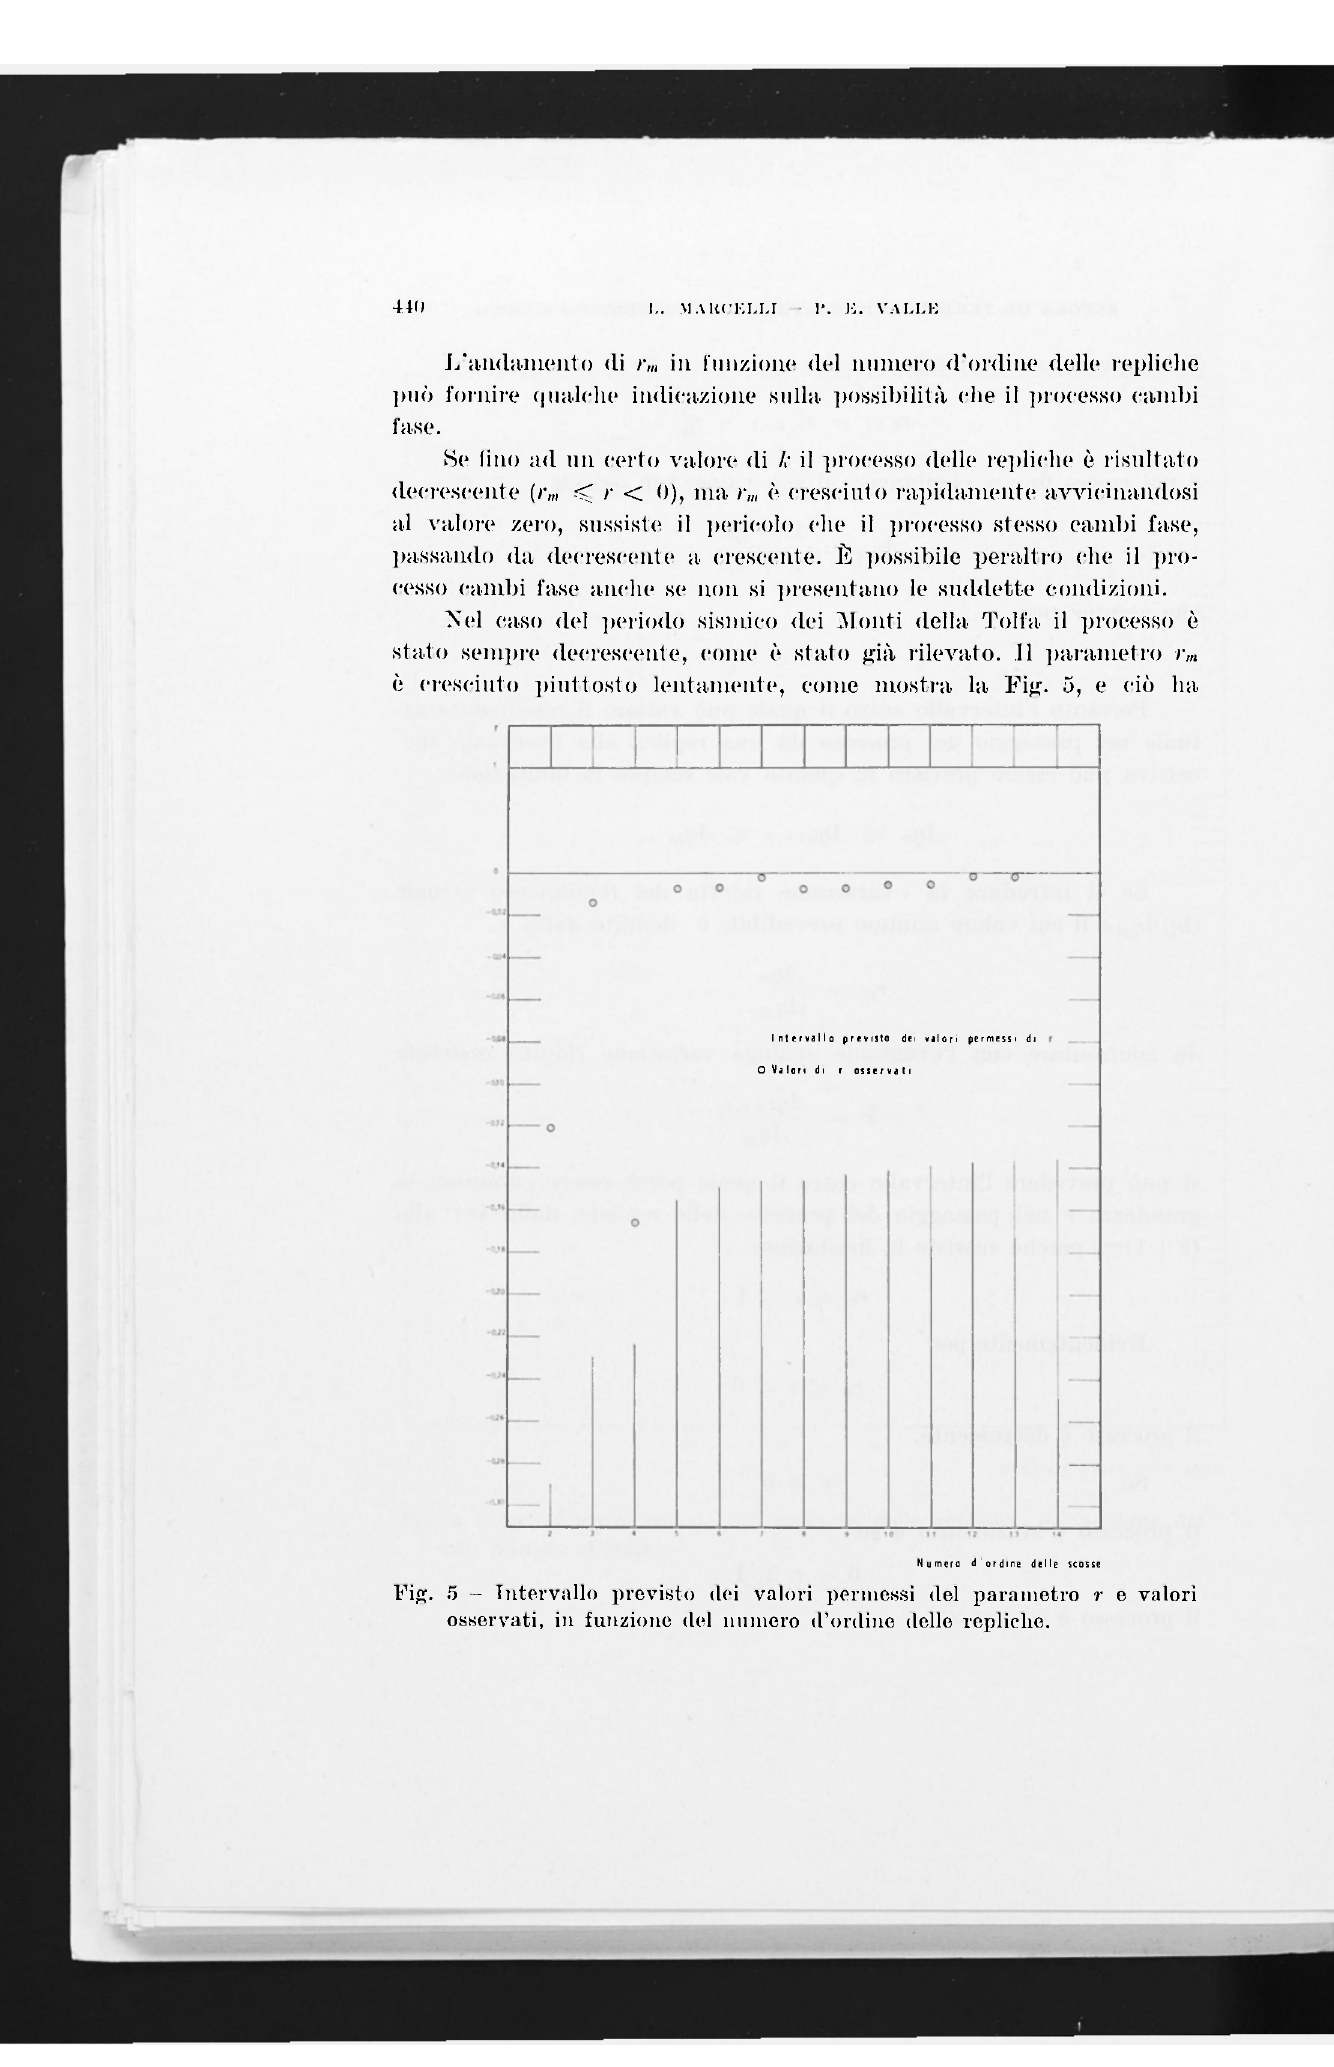
Fig. 5 - Intervallo previsto dei valori permessi del parametro r e valori osservati, in funzione del numero d'ordine delle